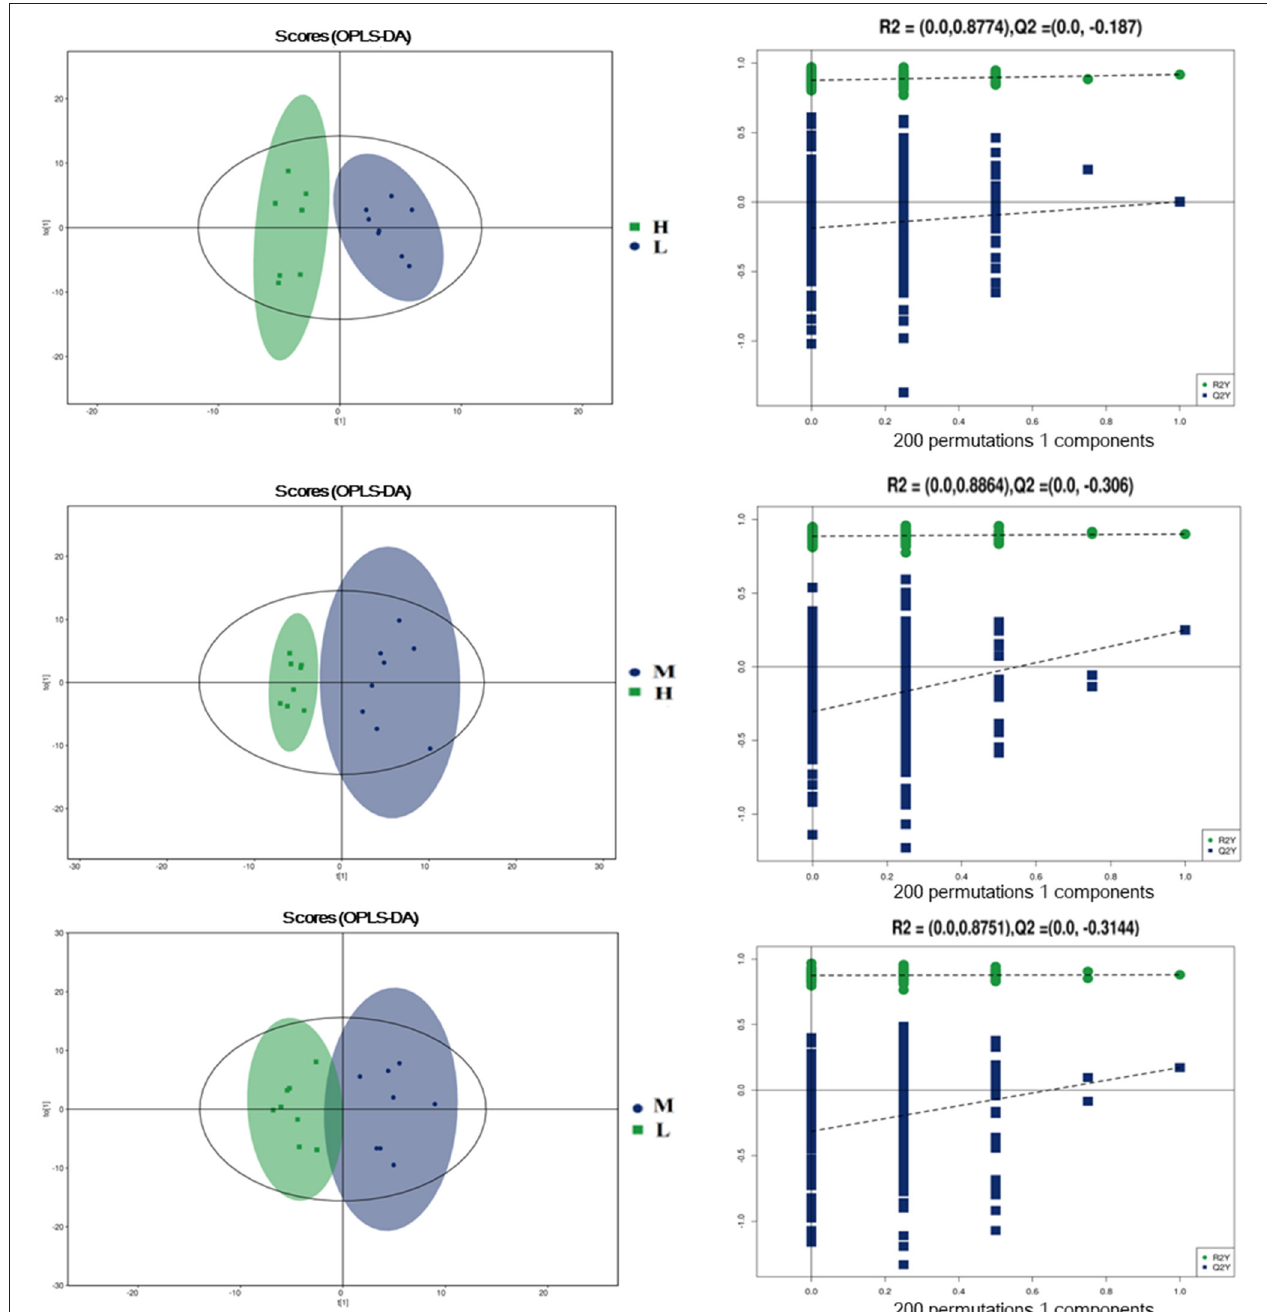
FIGURE 5 | Orthogonal partial least squares discriminant analysis (OPLS-DA) score plots in negative electrospray ionization mode (ESI-) metabolomics profiles of plasma. L = 1,050 mg/kg choline group; M = 1,850 mg/kg choline group; H = 2,650 mg/kg choline